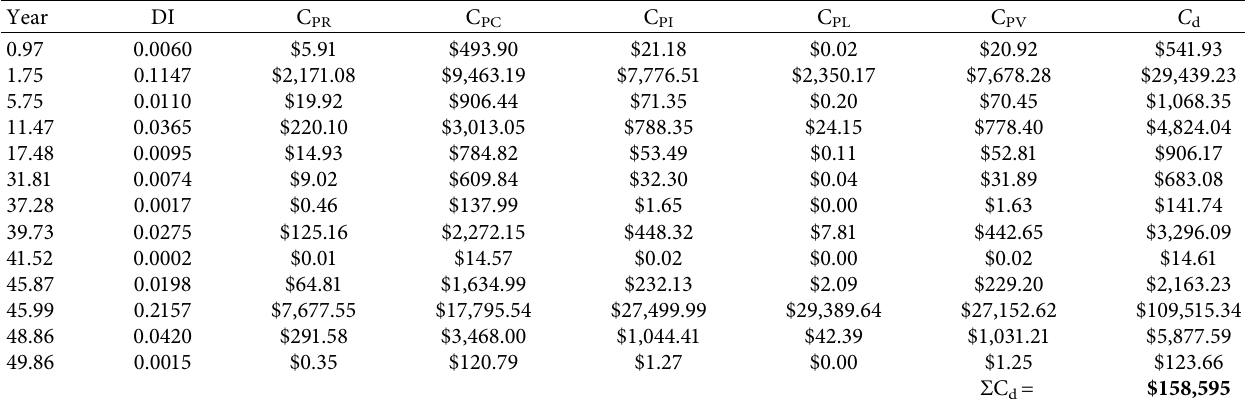
Table 6: Expected damage cost in the life-cycle of the 4-story